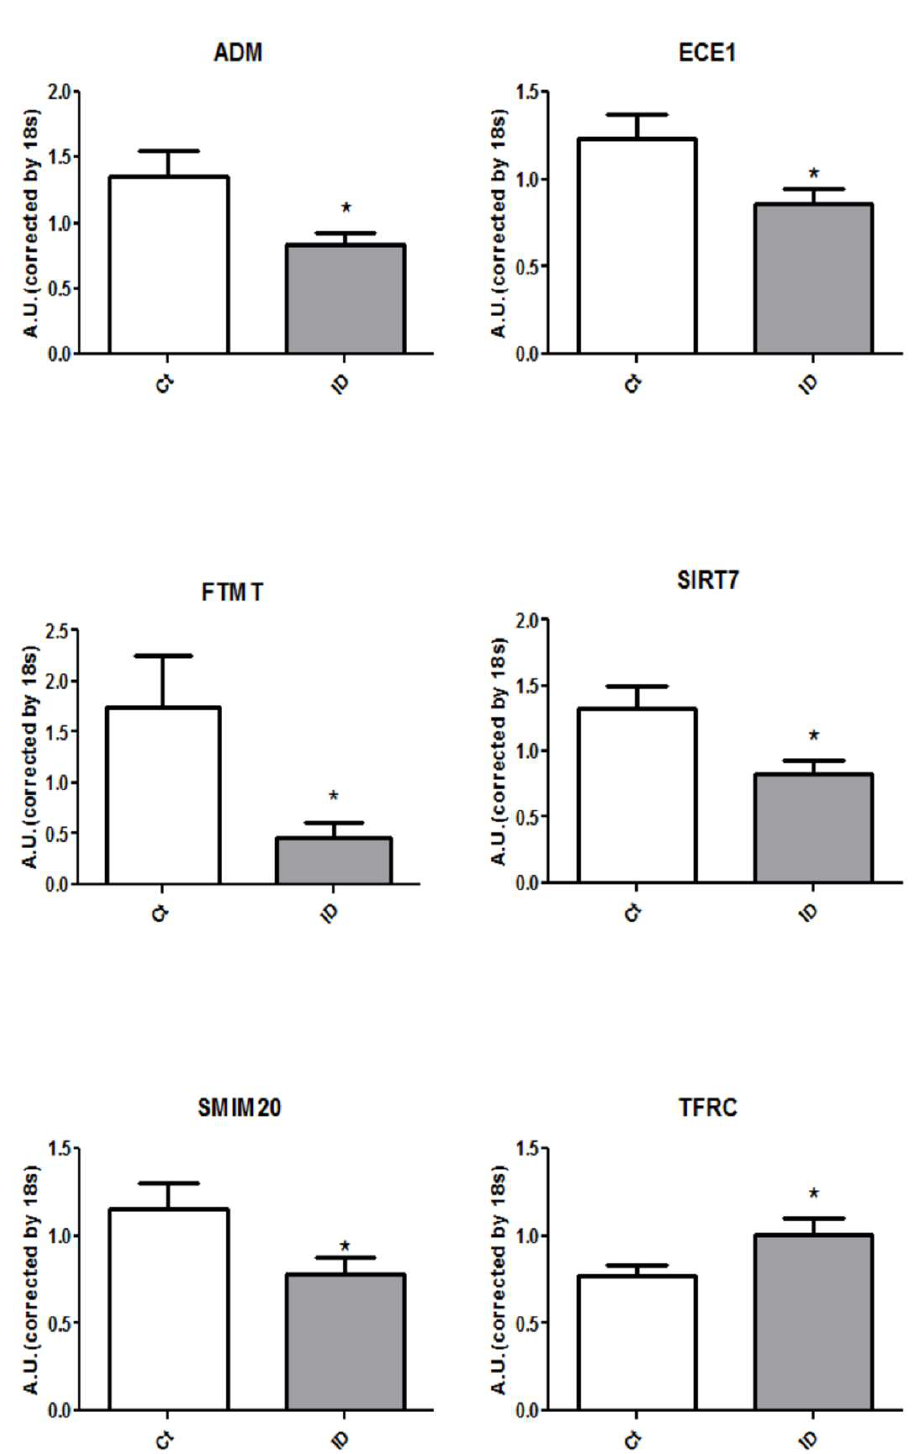
Figure 2. ADM , ECE1 , FTMT , SIRT7 , SMIM20 and TFRC genes are differentially expressed in the whole blood of ID (iron deficiency) patients versus the control ones. Graph representation of the 6 mRNA levels from blood in both studied populations. Data were normalized by the 18 s and expressed as mean ± SEM (* p < 0.05 vs. Control).